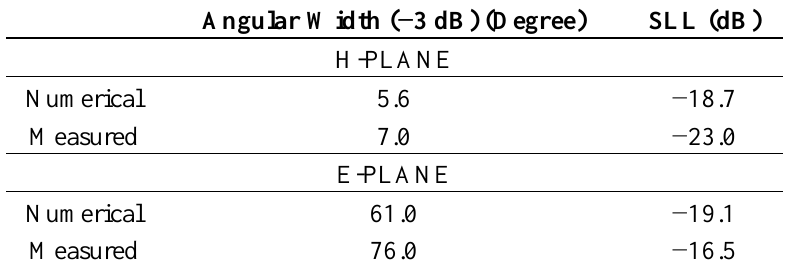
Figure 8. Radiation patterns of the transmitting slot antenna over both horizontal ( Left ) and vertical ( Right ) planes: a comparison between calculated and measured results. Table 2. Radiation parameters of transmitting antennas: comparison between calculated and measured